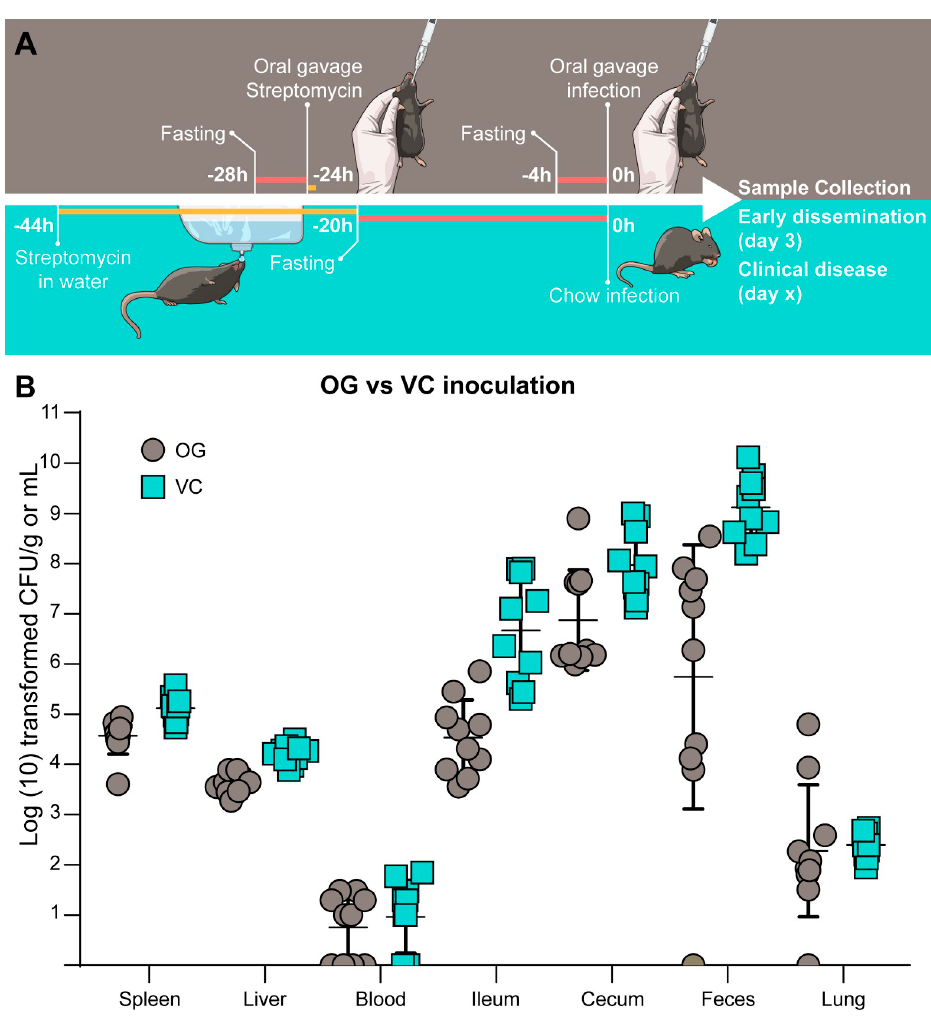
Fig 2. Comparison of tissue loads in mice infected by VC and OG. (A) Schematic representation of the OG (top) and VC (bottom) infections. (B) Bacterial numbers in tissues from mice infected either by OG or VC 3 days p.i. n = 10 mice. Symbols represent individual mice. Error bars represent the mean ± SD. Tissues where bacterial load was below the level of detection are given a value of “1” for visualization purposes.